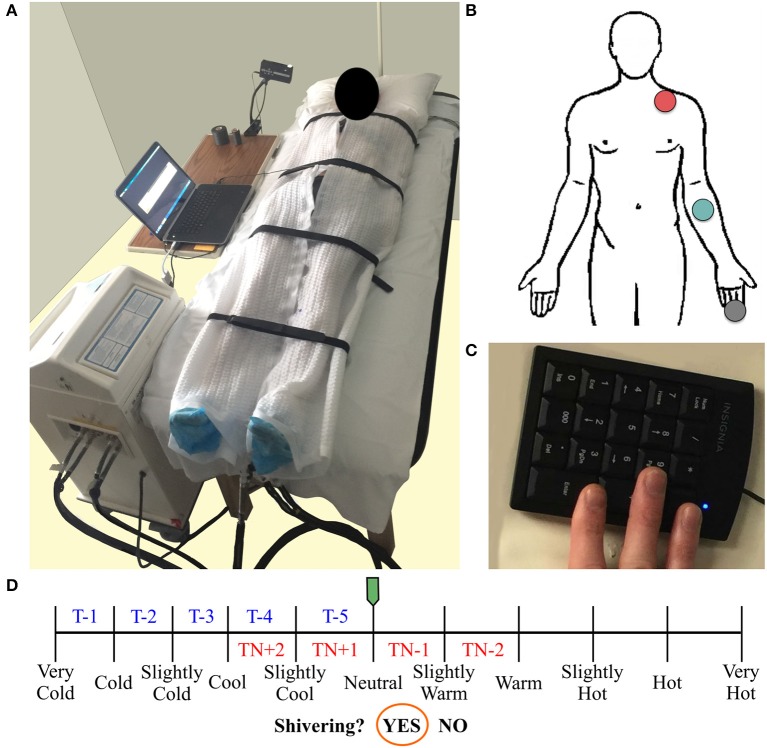
Participant's setup used for an individualized, perception-based cooling protocol (A). Two water-circulating blankets connected to a Blanketrol® III hyper-hypothermia system are secured around the participant. Diagram of the skin temperature probe locations (human body outline adapted from a free graphics library: http://clipart-library.com) (B). Skin temperature was measured in the supraclavicular region (red circle), on the anterior portion of the forearm (green circle), and on the distal end of the middle finger (gray circle). A laptop computer logs water temperature and runs a thermoesthesia graphical user interface (tGUI) program. The tGUI records feedback from an external keypad (C) attached to the participant's right hand (positioned underneath the blankets during cooling) and updates a visual display projected above the patient bed in real-time. Schematic of the perception-based cooling protocol water temperature adjustment guide (blue and red text) overlay on the tGUI visual interface (D). During the protocol, the participant uses two buttons to move the green slider along the continuum of temperature ratings. The slider's position determines how to alter the current water temperature set point (TN during thermoneutral (red text) or T during cooling (blue text) phases; see section Individualized, Perception-Based Cooling Protocol for details). A third button can be pressed to move the orange circle and indicate if shivering is active (“Yes”) or inactive (“No”).